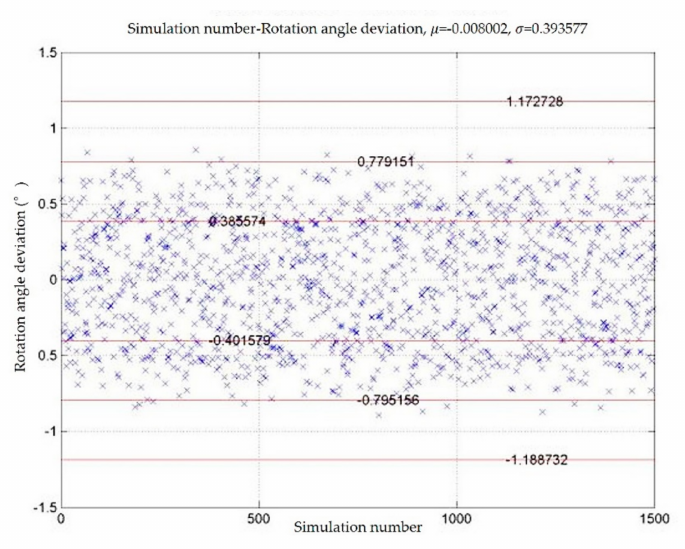
Figure 4. x deviation of rendezvous and docking results and distribution of ± σ , ± 2 σ , ± 3 σ .